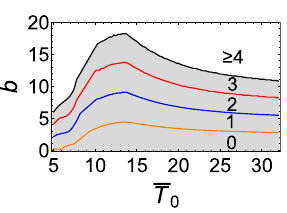
Fig. 13 The relation between the number of the resonances and the parameters ¯ T 0 and ¯ b for f ( T ) = −